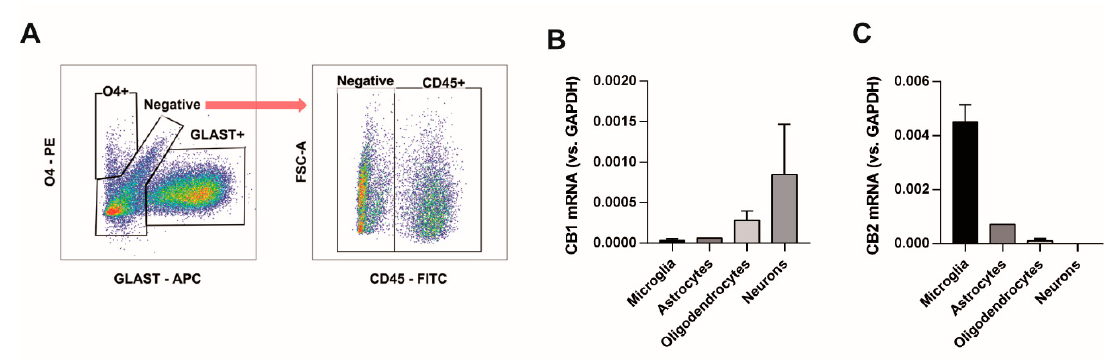
Figure 5. CB2 receptors are expressed by microglial cells at DIV12. Cells from mixed rat cortical primary cultures were collected and immunolabeled to separate different cell types. ( A ) Representative dot plot of fluorescence-activated cell sorting of cells based on the surface expression of O4 (mature oligodendrocytes), GLAST (astrocytes) and CD45 (microglial cells). The negative fraction was enriched in neuronal cells. ( B ) Relative CB1 receptor mRNA expression by real-time PCR in sorted cells. ( C ) Relative CB2 receptor mRNA expression by real-time PCR in sorted cells. PCR reactions were performed in triplicates from 2 independent experiments. Mean +/ − standard error of the mean is shown.